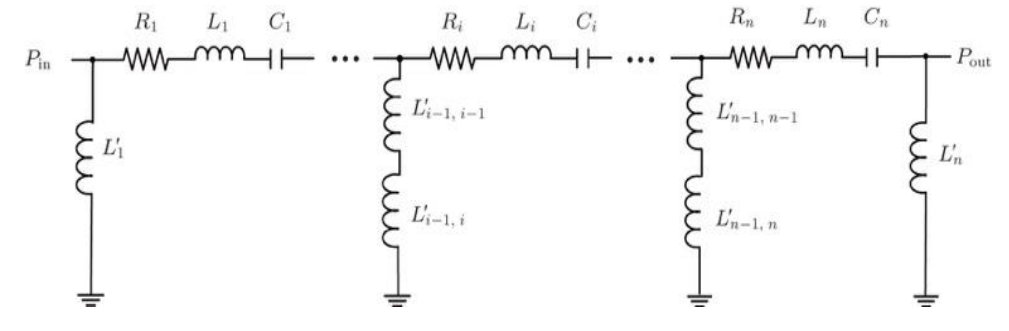
Figure 3. General equivalent circuit of the dual band pass filter